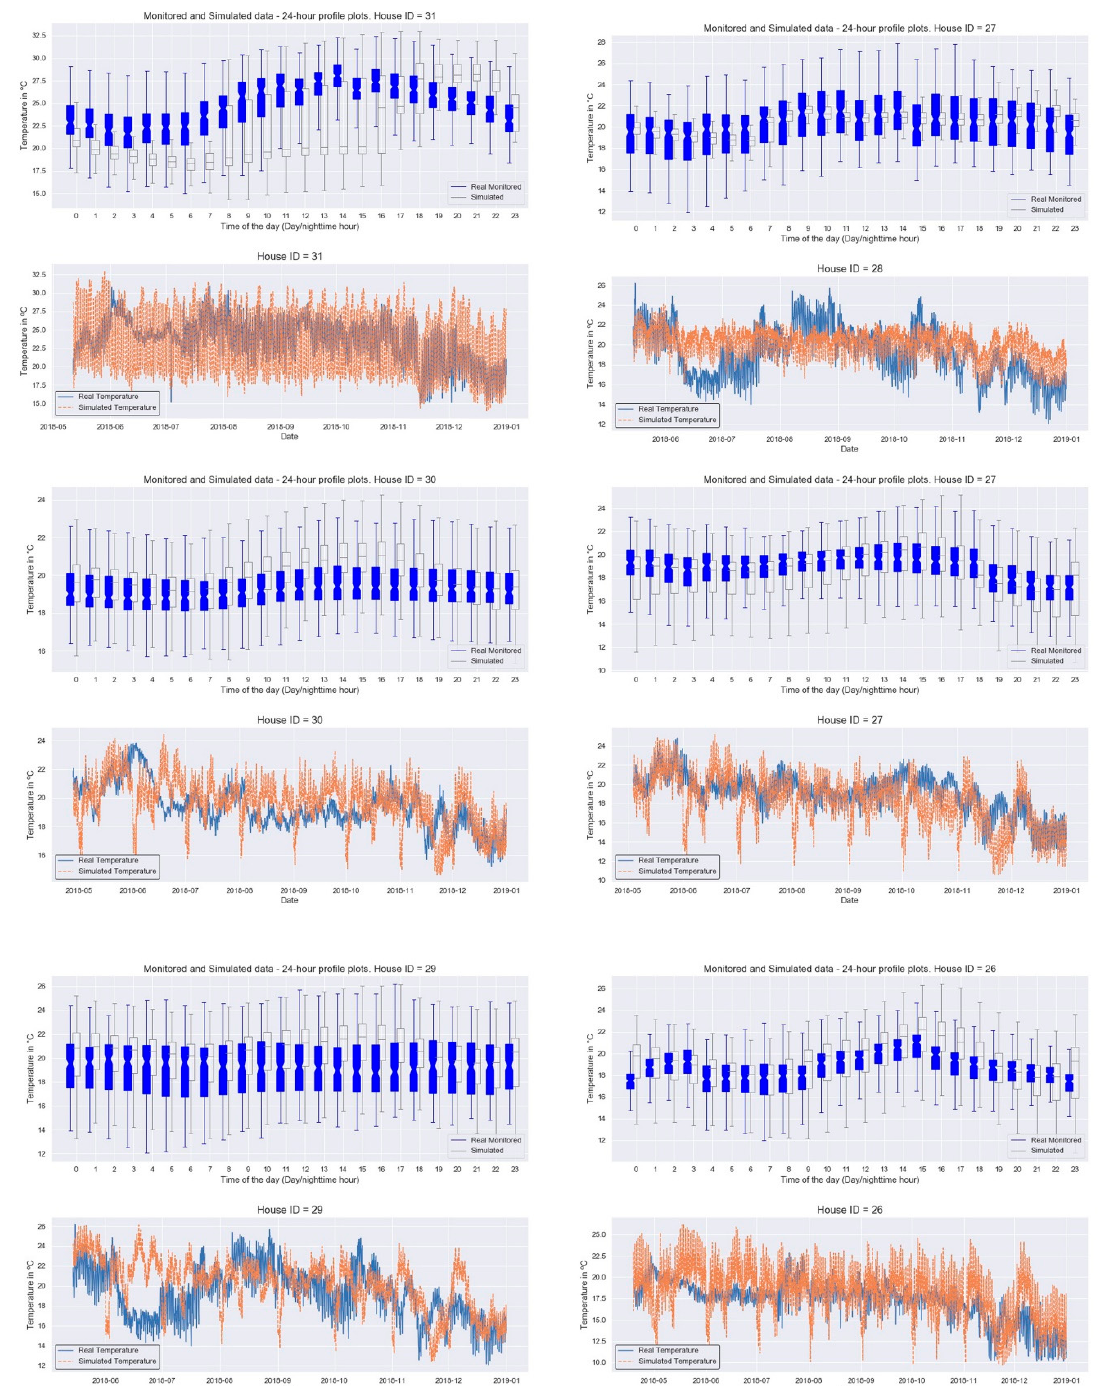
Figure A3. Results of the calibration of the models used for simulation—page 3.